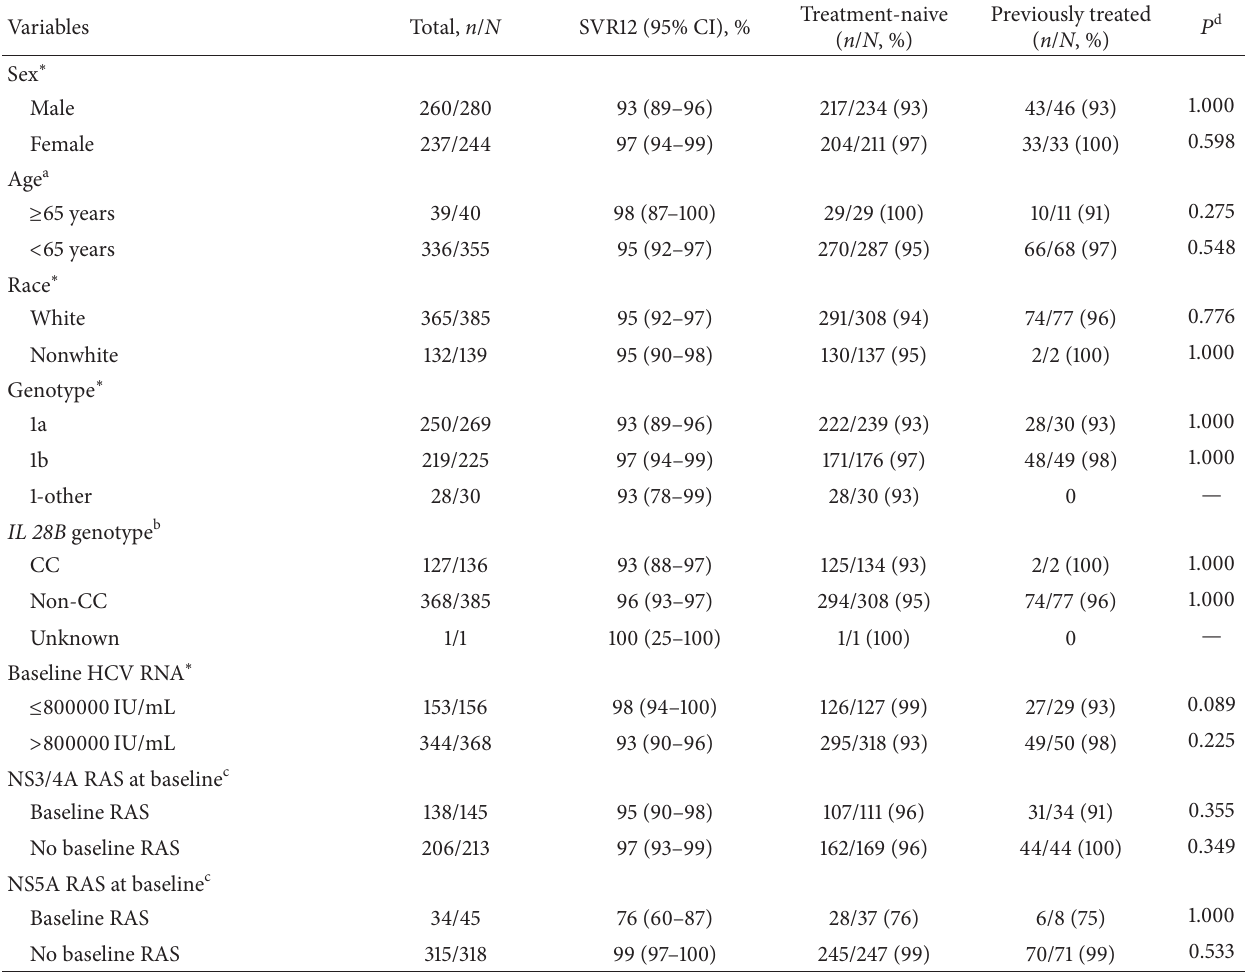
Table 3: Subgroup analysis of